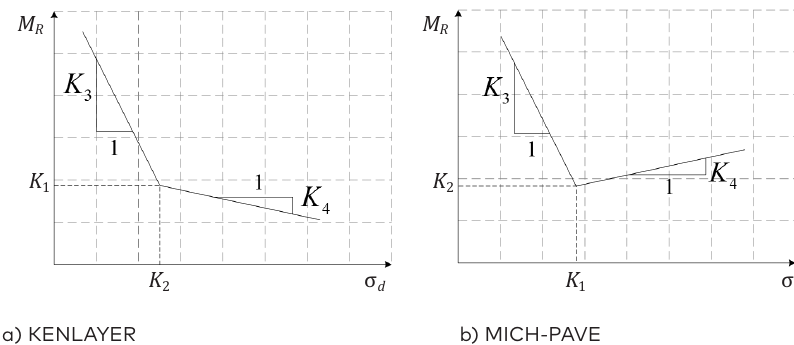
Figure 2. Graphical representations of the bilinear models